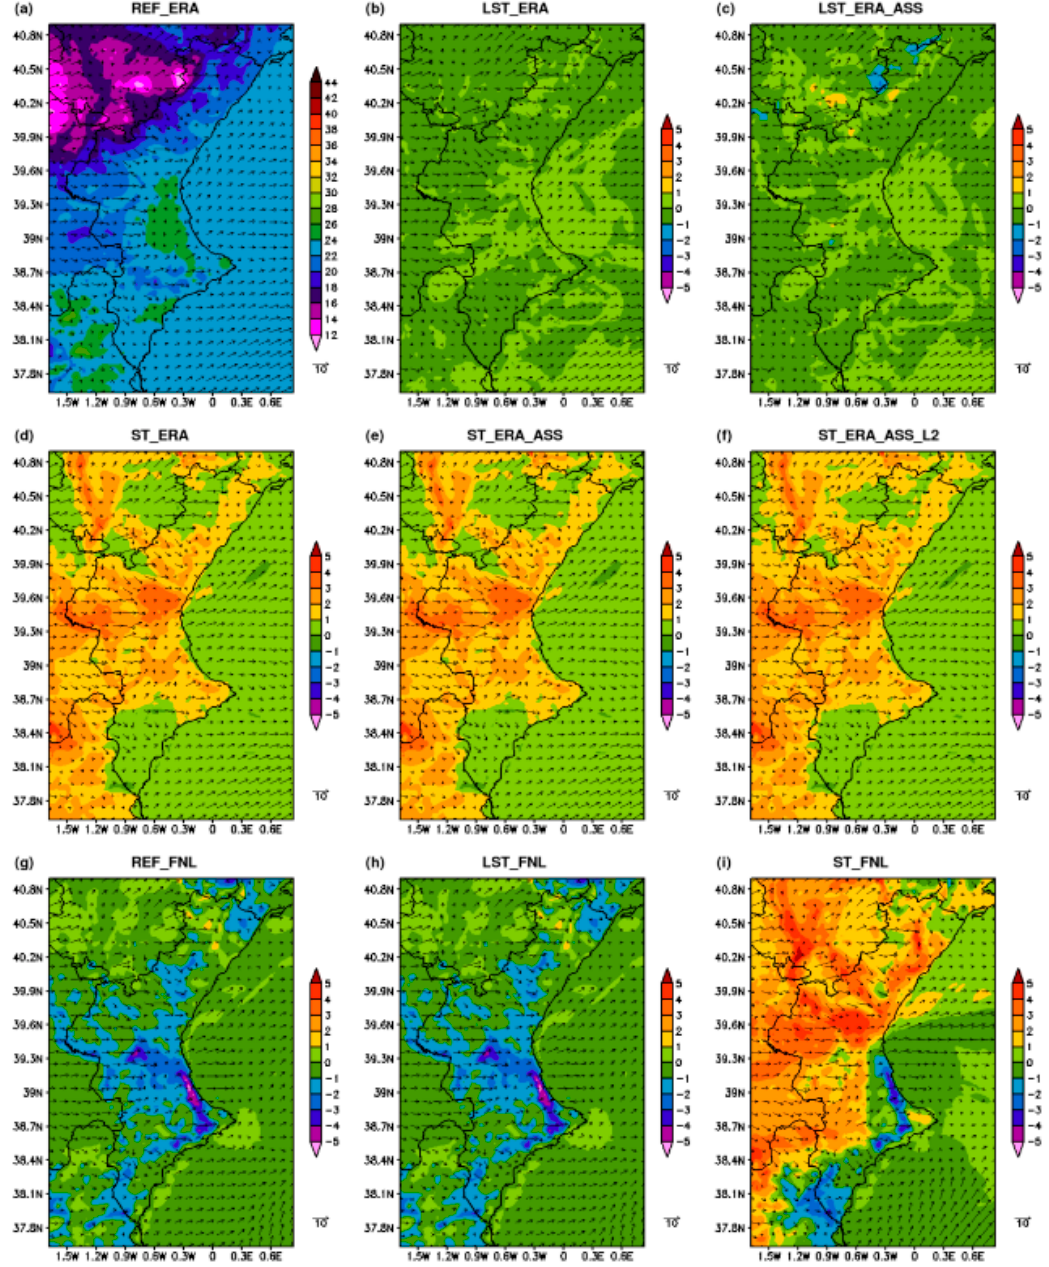
Figure 8. Same as Figure 5, but for the forecasted 2-m minimum temperature (°C) and near-surface wind field (m/s) at 06 UTC.